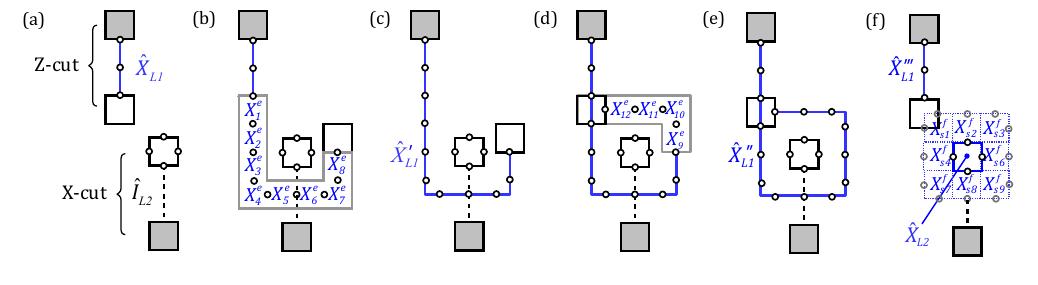
Figure 37: A braid on a Z-cut qubit, where the lower Z-cut hole is passed around the upper X-cut hole of an X-cut qubit. The braid’s effect on X operator of the Z-cut qubit 1 is shown. L 1 (a) Z-cut qubit (above) and X-cut qubit (below) with corresponding logical operators; data qubits are shown as open circles. (b) Extension for first move in braid, where data qubits are measured along X , with measurement outcomes X e , X e ,... X e . (c) X operator is extended in L 1 1 2 8 length to X (cid:48) . (d) Extension for second move in braid, where data qubits are measured along L 1 X with measurement outcomes X e ,... X e . (e) X (cid:48)(cid:48) operator is extended in length, comprising L 1 9 12 the original chain plus a closed loop of data qubit operators, the loop enclosing the upper hole of the X-cut qubit. (f) The loop part of the X (cid:48)(cid:48) operator is moved through the enclosed L 1 stabilized cells, leaving a loop of X data qubit operators that is equal to X on the second L 2 qubit, with X unchanged from before the braid (other than possible sign changes). Figure L 1 from Ref. (Fowler, Mariantoni, Martinis and Cleland, 2012a).